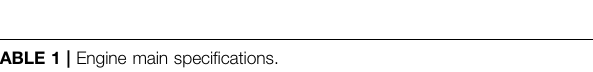
TABLE 1 | Engine main speci fi